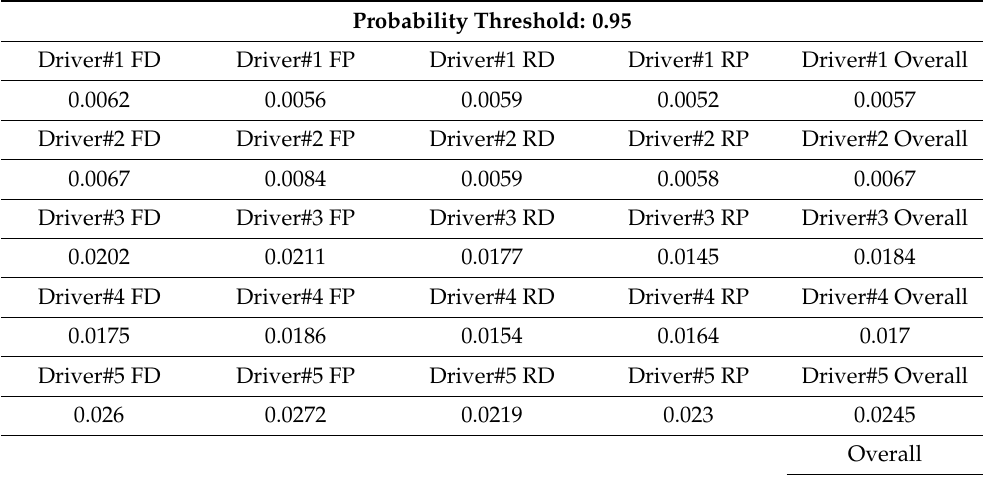
Table 9. Mean square error for each driver, each driver’s individual brakes, and overall values with probability threshold at